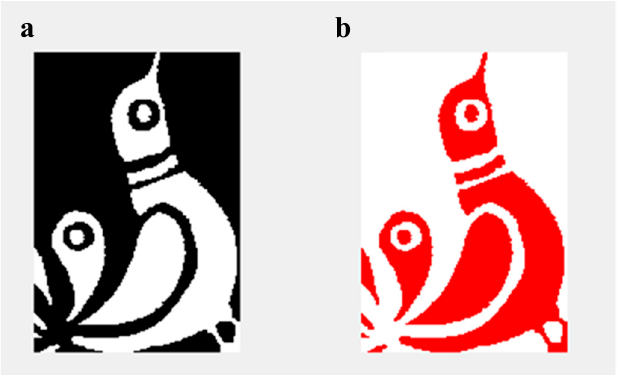
Figure 5. An original picture on a “Matyó” embroidery (bird pattern, 126×184 pixel) used for encoding information ( a ) and its Run Length Encoding (RLE) compressed version as decoded by MALDI-TOF MS ( b ).